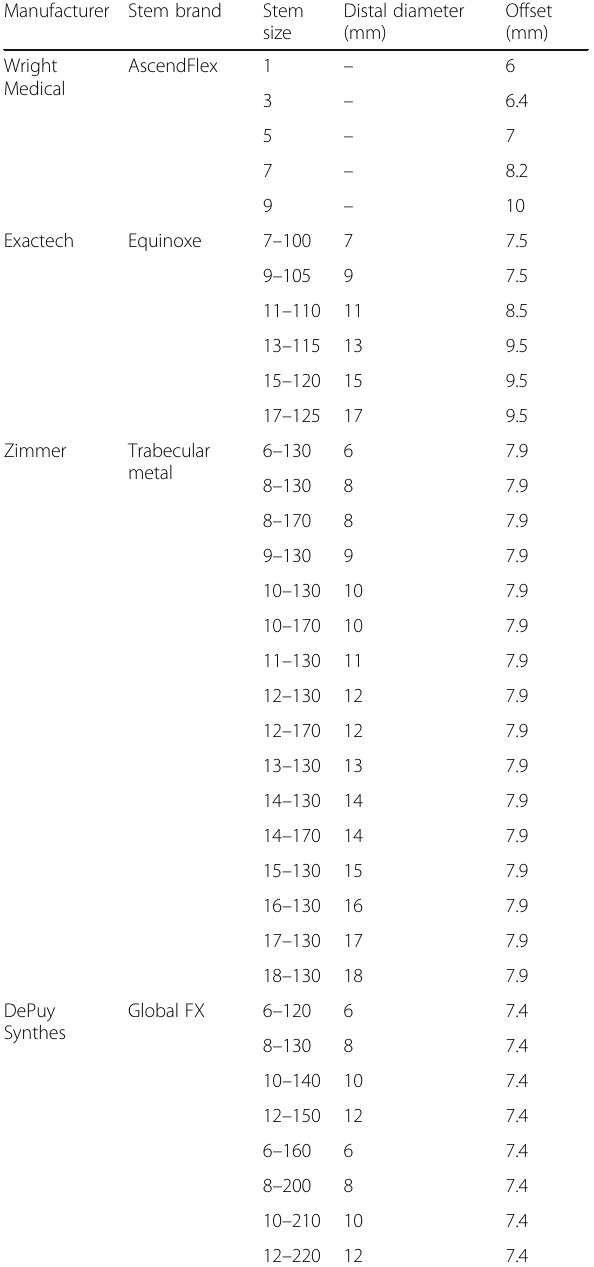
Table 1 Design characteritics of humeral stems by different